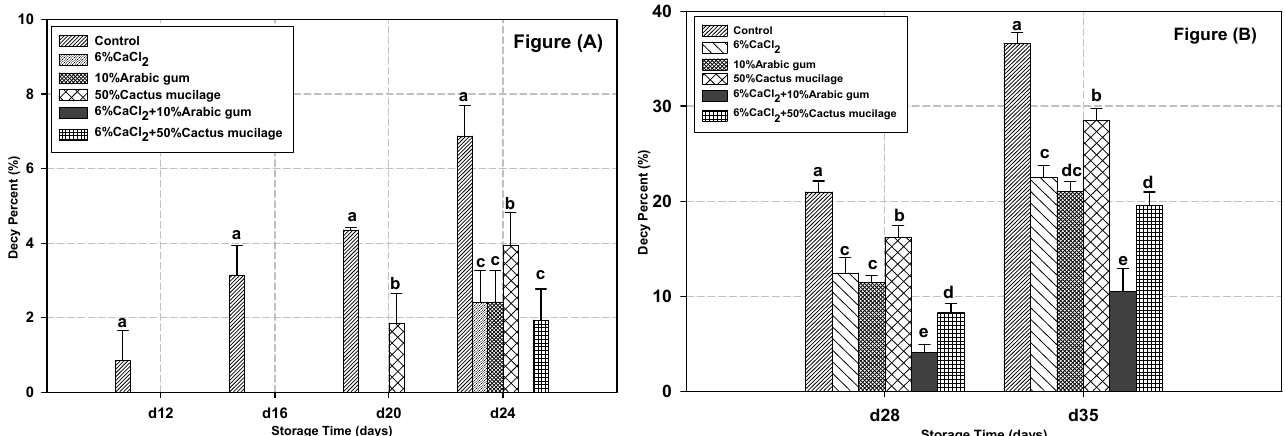
Fig. 2 (A, B): Effect of natural substance combination with CaCl2 on decay tomatoes fruit during cold storage at (10 °C). Means followed by the same letter are not significantly different (Duncan’s multiple range test, P > 0.05)